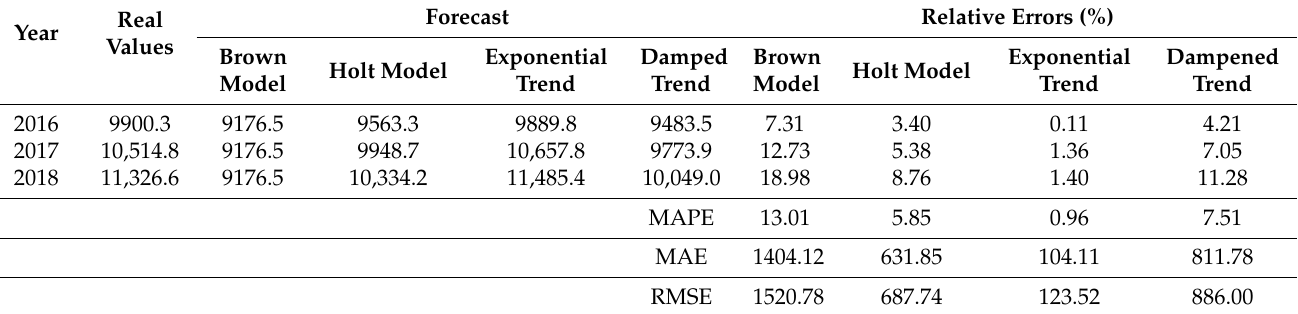
Table 3. Real values, forecasts, relative errors and MAPE’s for revenue of Zachodniopomorskie voivodeship in 2016–2018 (exponential smoothing models, million PLN).